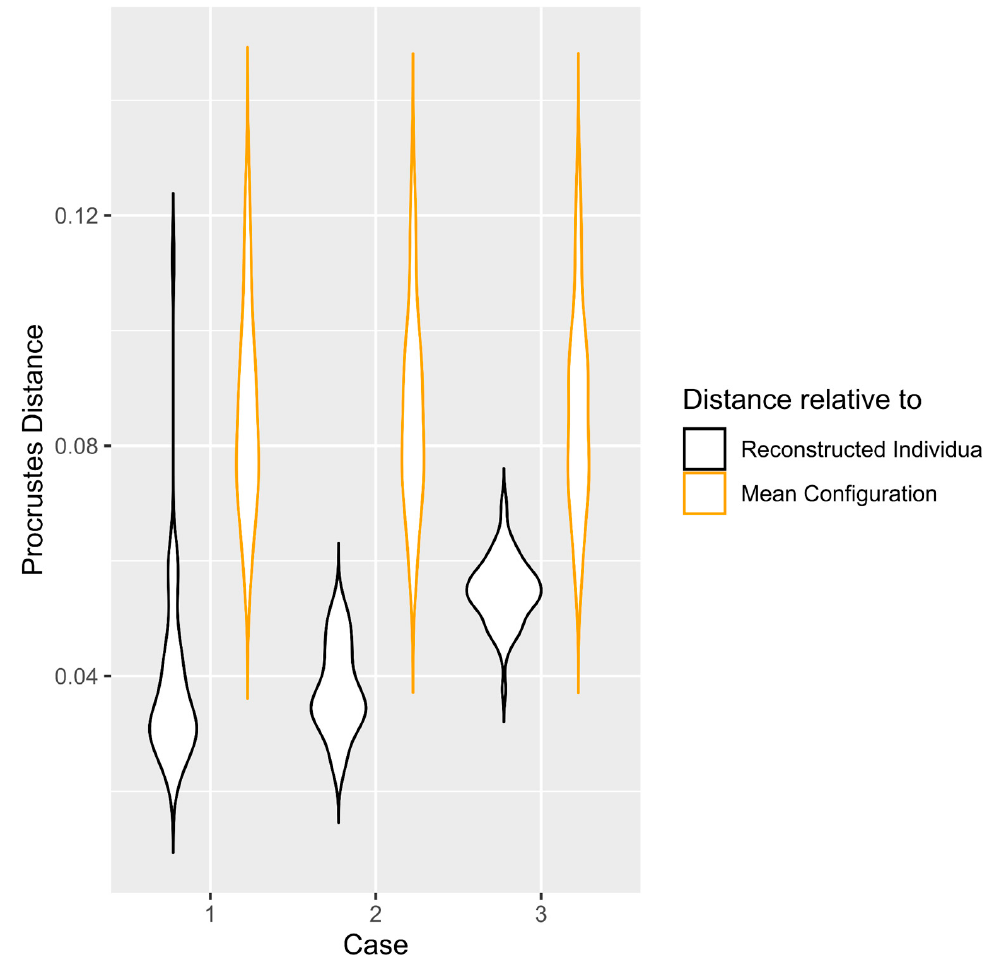
Figure 3. Violin plots showing the Procrustes distances between the original and reconstructed landmark configurations (in black) and between the original and average landmark set (in yellow), for the three cases. The data correspond to the full sample and the subsample of Italians, since the reconstructions in both samples had similar Procrustes distances in relation to the original zygomatics (see